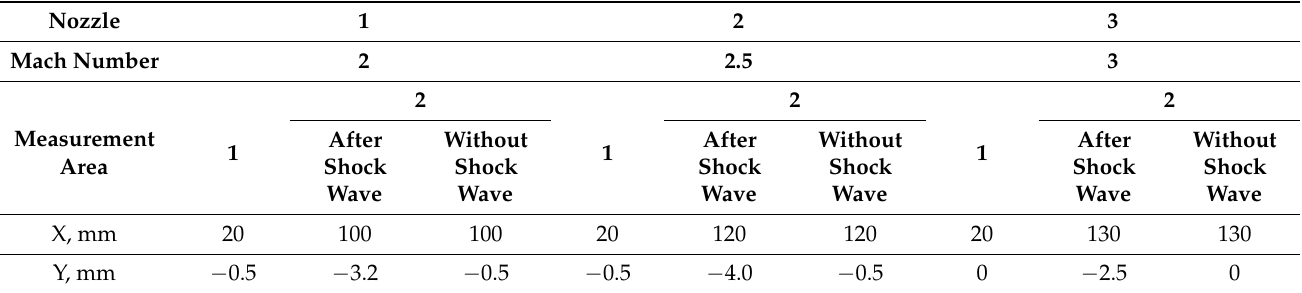
Table 1. Coordinates of measurement